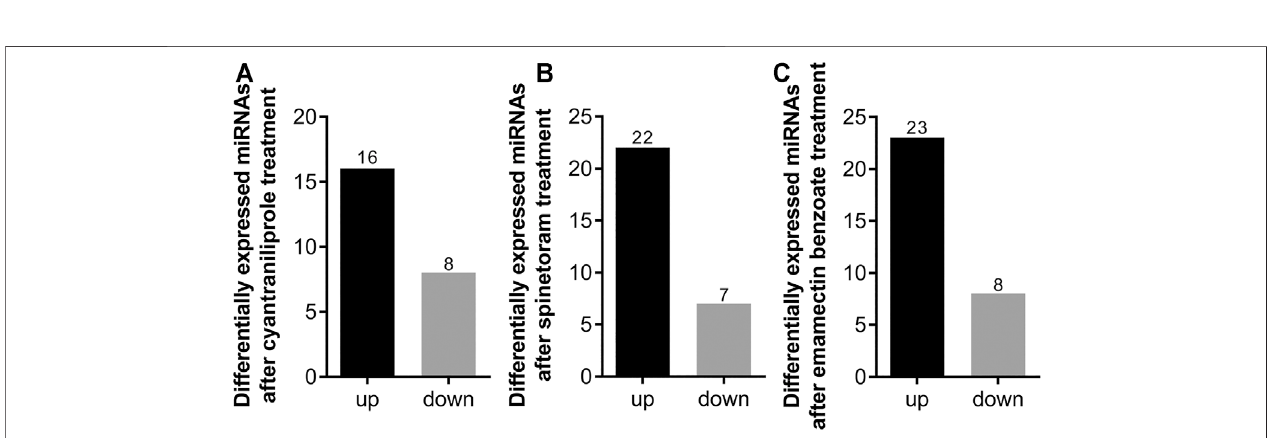
FIGURE 3 | Number of differentially expressed miRNAs after insecticide treatment. (A) Number of differentially expressed miRNAs after cyantraniliprole treatment. (B) Number of differentially expressed miRNAs after spinetoram treatment. (C) Number of differentially expressed miRNAs after emamectin benzoate treatment.